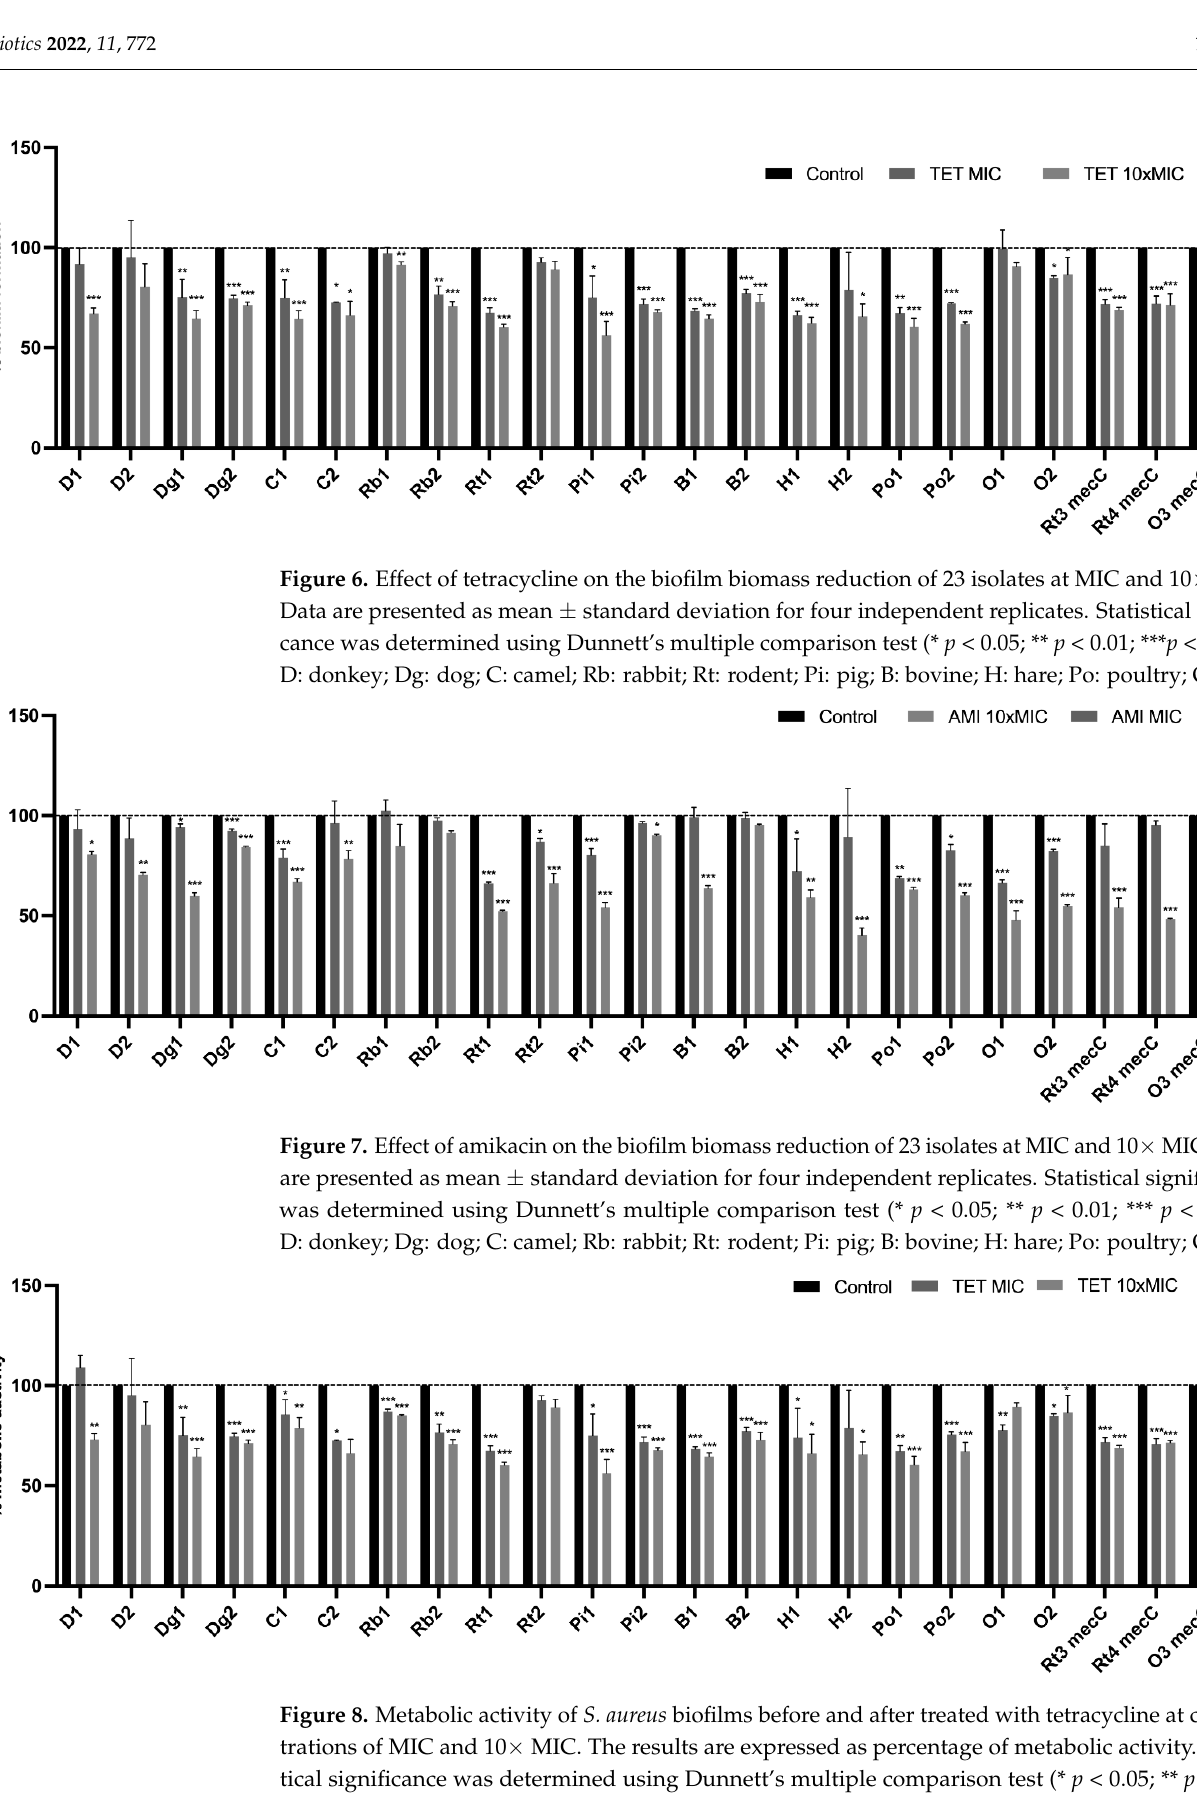
Figure 8. Metabolic activity of S. aureus biofilms before and after treated with tetracycline at concen- trations of MIC and 10× MIC. The results are expressed as percentage of metabolic activity. Statisti- cal significance was determined using Dunnett ’ s multiple comparison test (* p < 0.05; ** p < 0.01; ***